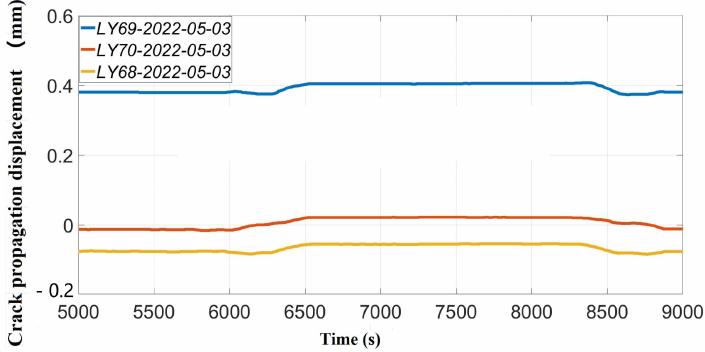
Figure 11. Crack signal waveform collected by distributed fiber Bragg grating crack sensor.